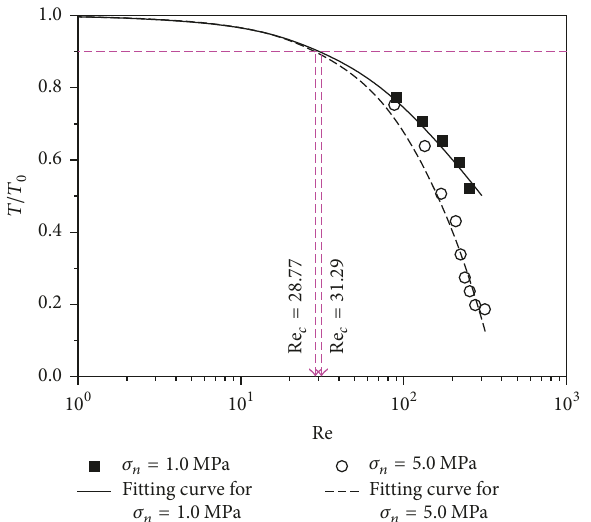
Figure 10: Relationships between T / T 0 and Re based on the data replotted from Ranjith and Darlington ([89], Figure 8 ).